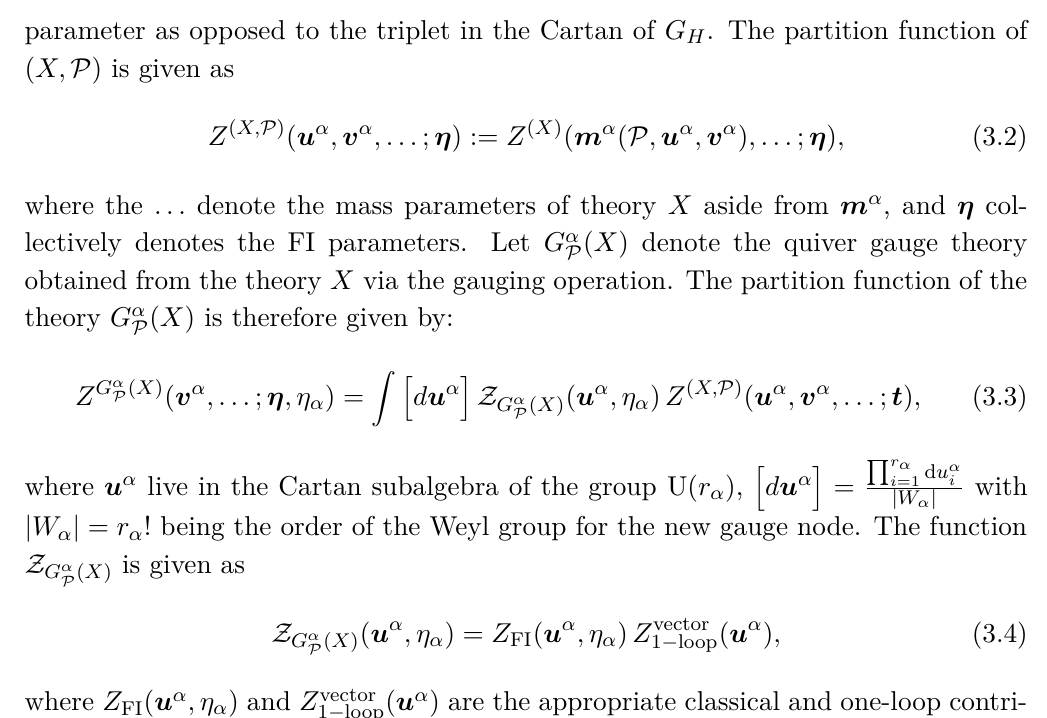
Figure 8 . A gauging operation G α generic quiver gauge theory (represented by the grey